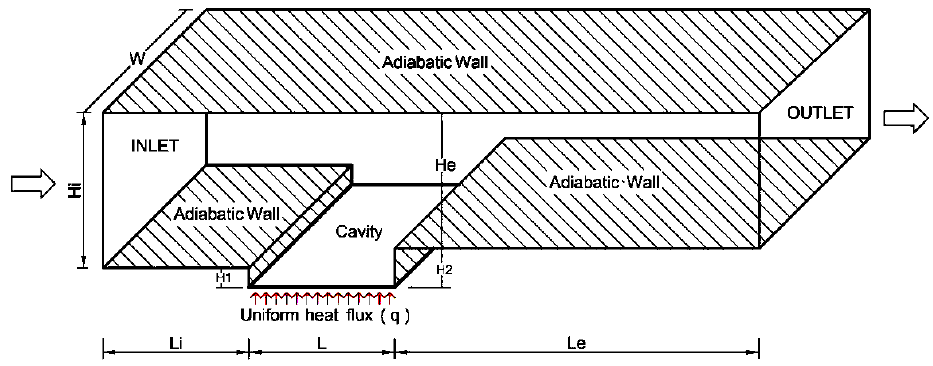
Figure 1. Schematic diagram with dimensions for the shallow cavity in a channel.